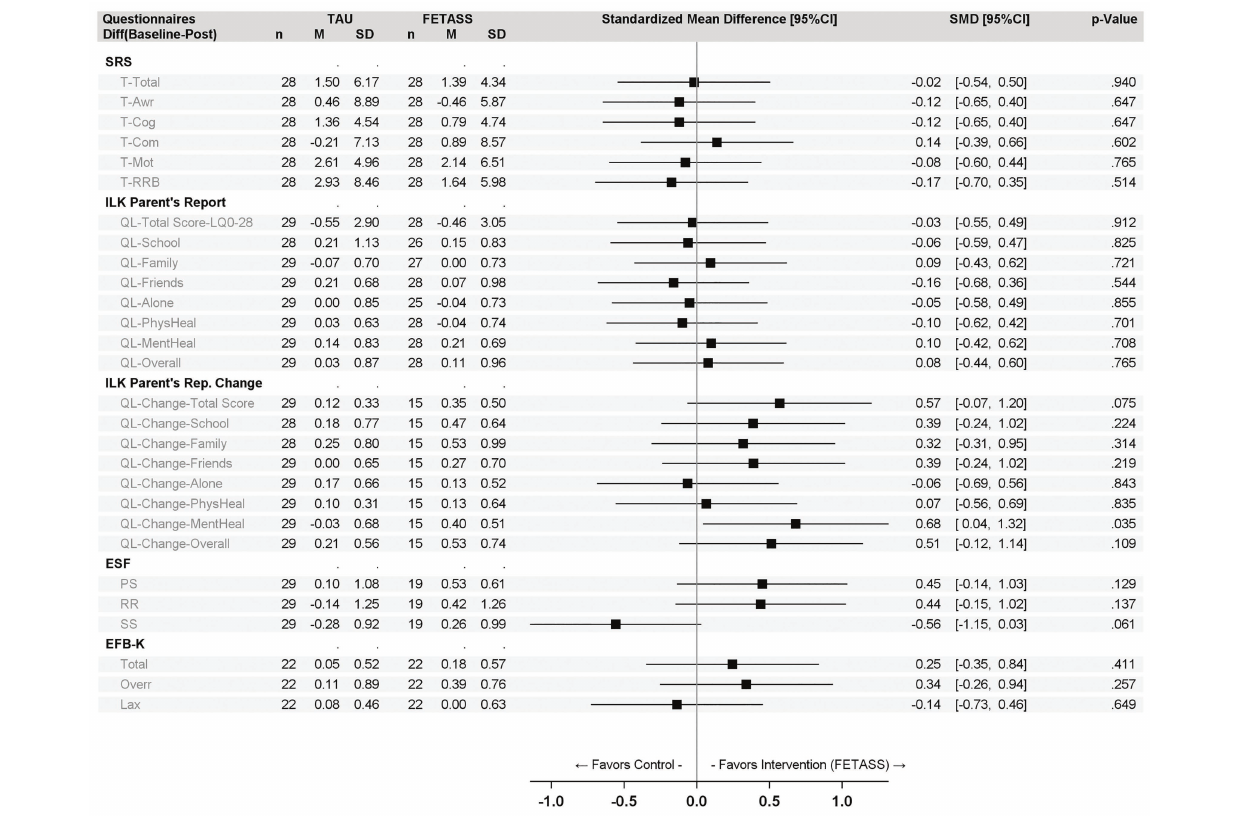
FIGURE 2 | Forest plot with point estimates and 95% CI of standardized mean differences of the primary and secondary outcome measures (for abbreviations see Table 2